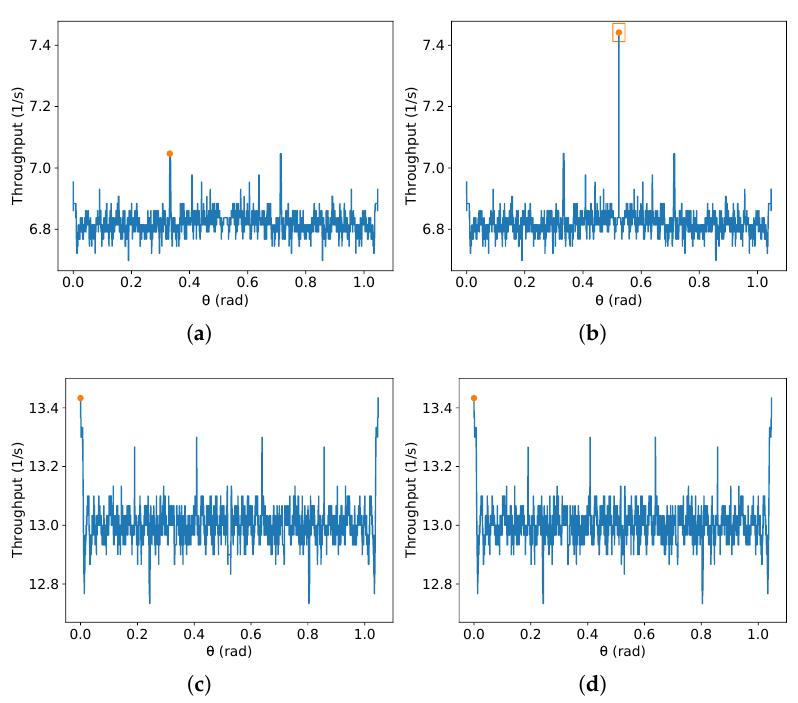
Figure 10. Similar to Figures 8 and 9 but using 10 7 and 10 7 + 1 equally spaced points for θ ∈ [0, π / 3). It continues in Figure 11. ( a ) For 10 7 samples, T = 43 s, s = 3 m, d = 1 m. ( b ) For 10 7 + 1 samples, T = 43 s, s = 3 m, d = 1 m. ( c ) For 10 7 samples, T = 30 s, s = 2.5 m and d = 0.66 m. ( d ) For 10 7 + 1 samples, T = 30 s, s = 2.5 m and d = 0.66 m.